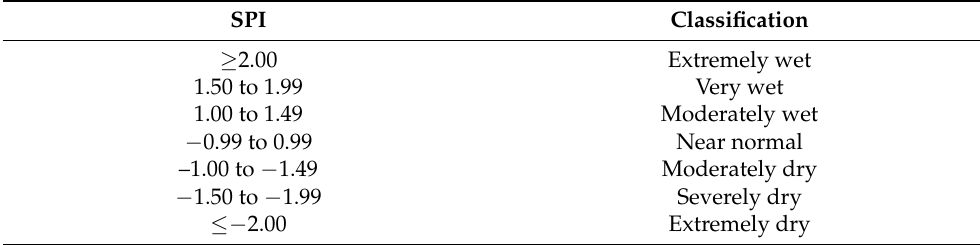
Table 3. SPI index classification. Adapted from McKee et al.